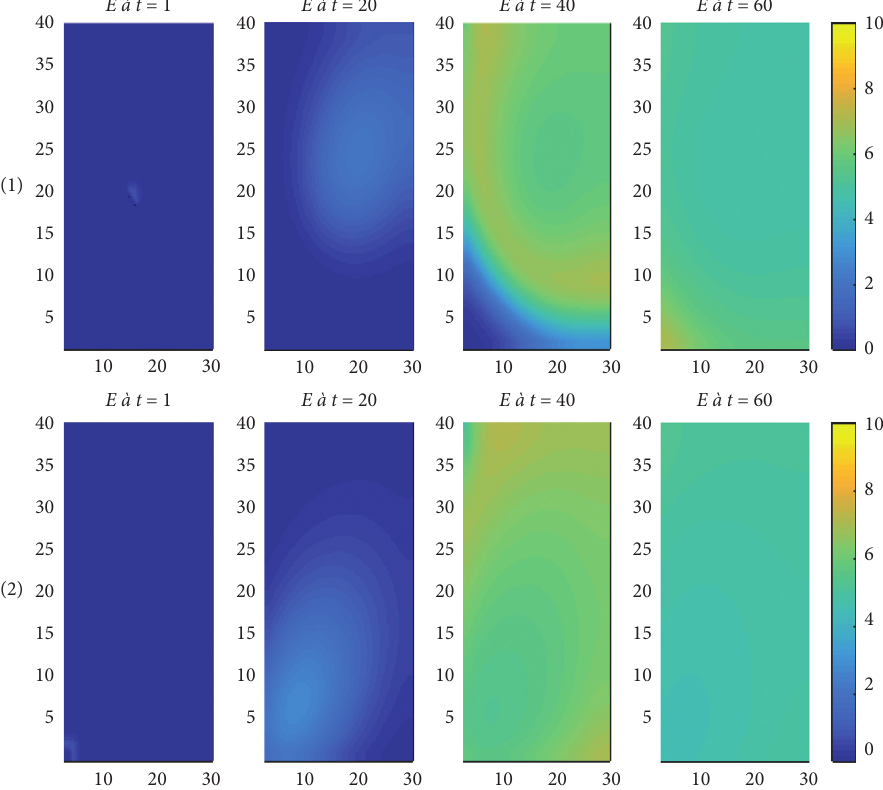
Figure 2: Exposed behavior within Ω without